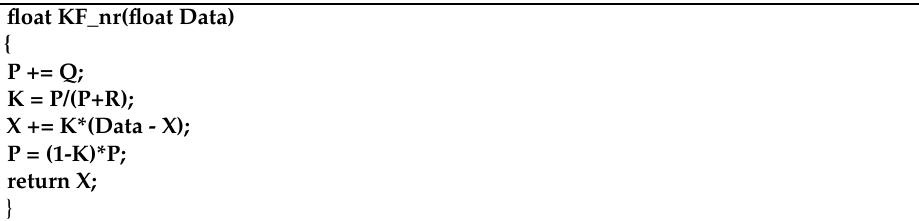
Table 1. The 1D Kalman filtering code implemented for measurement noise